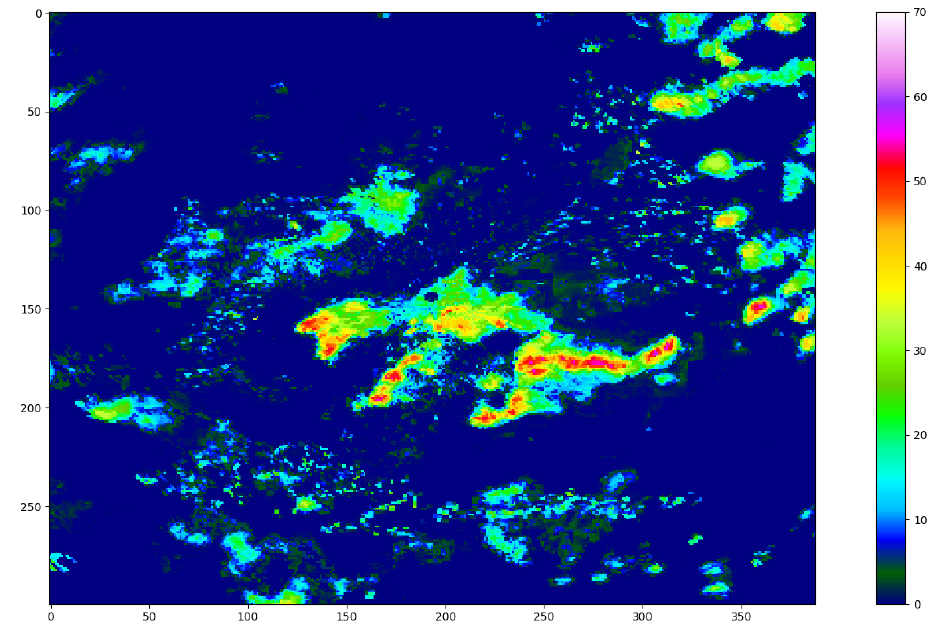
Figure 10. Predicted data for product R 01 (reflectivity at the lowest elevation angle, measured in dBZ with values ranging form 0 to 70) at 14:37:22